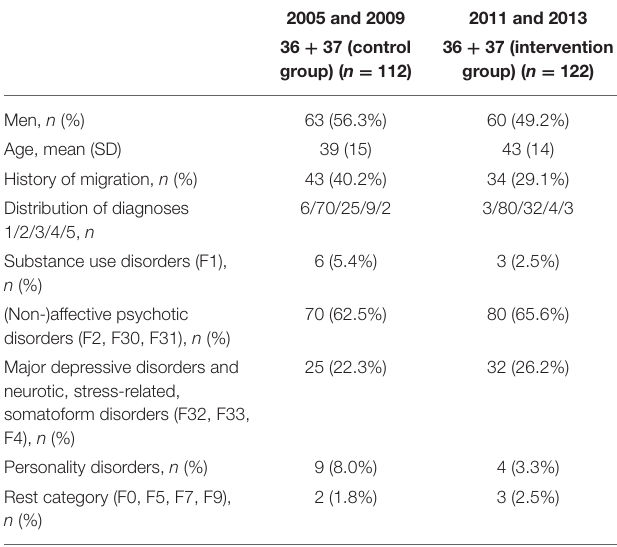
TABLE 1 | Gender, age, history of migration, and distribution of diagnoses ( n =